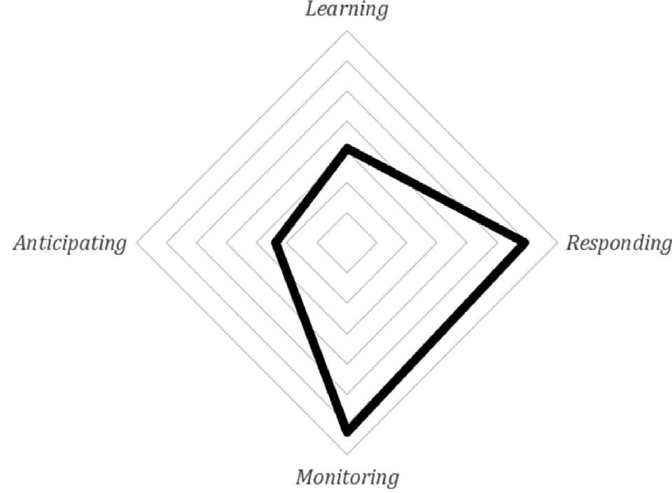
Figure 1. The RAG score for the four elements .